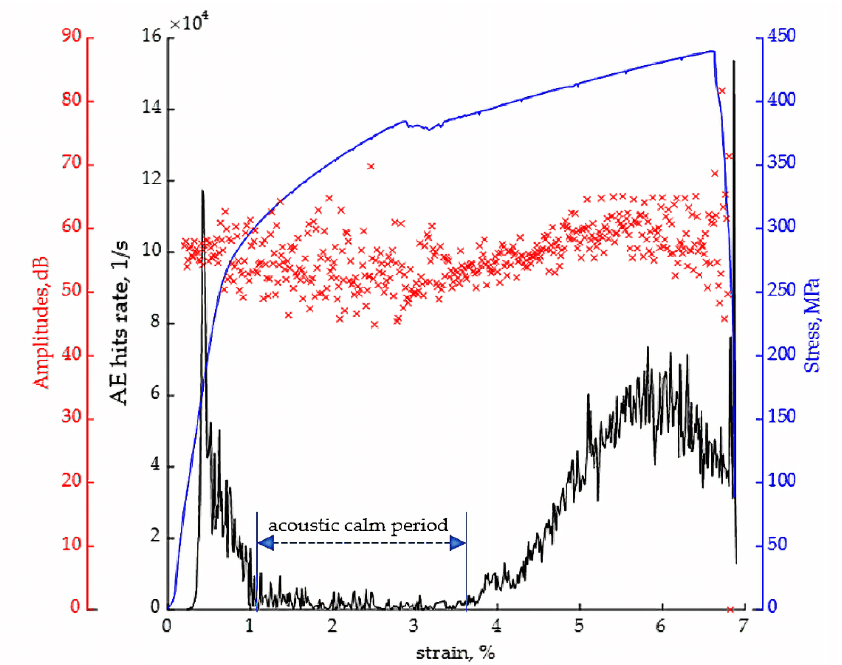
Figure 6. AE data recorded under tension of a specimen of a dissimilar welded joint with a lack of penetration.